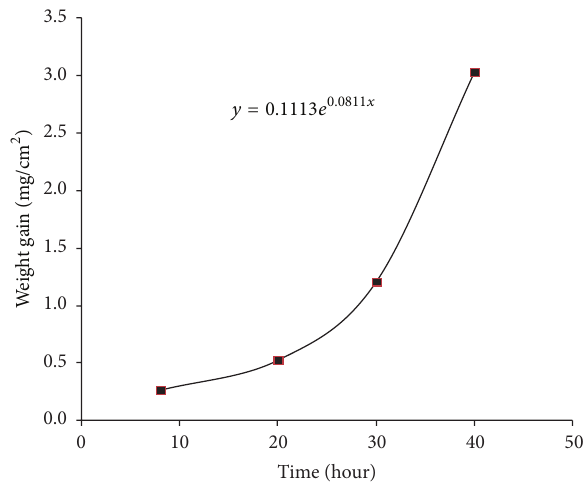
Figure 2: Weight gain per unit surface area versus time for welded AA6061 Al alloy sample heated at 600 ∘